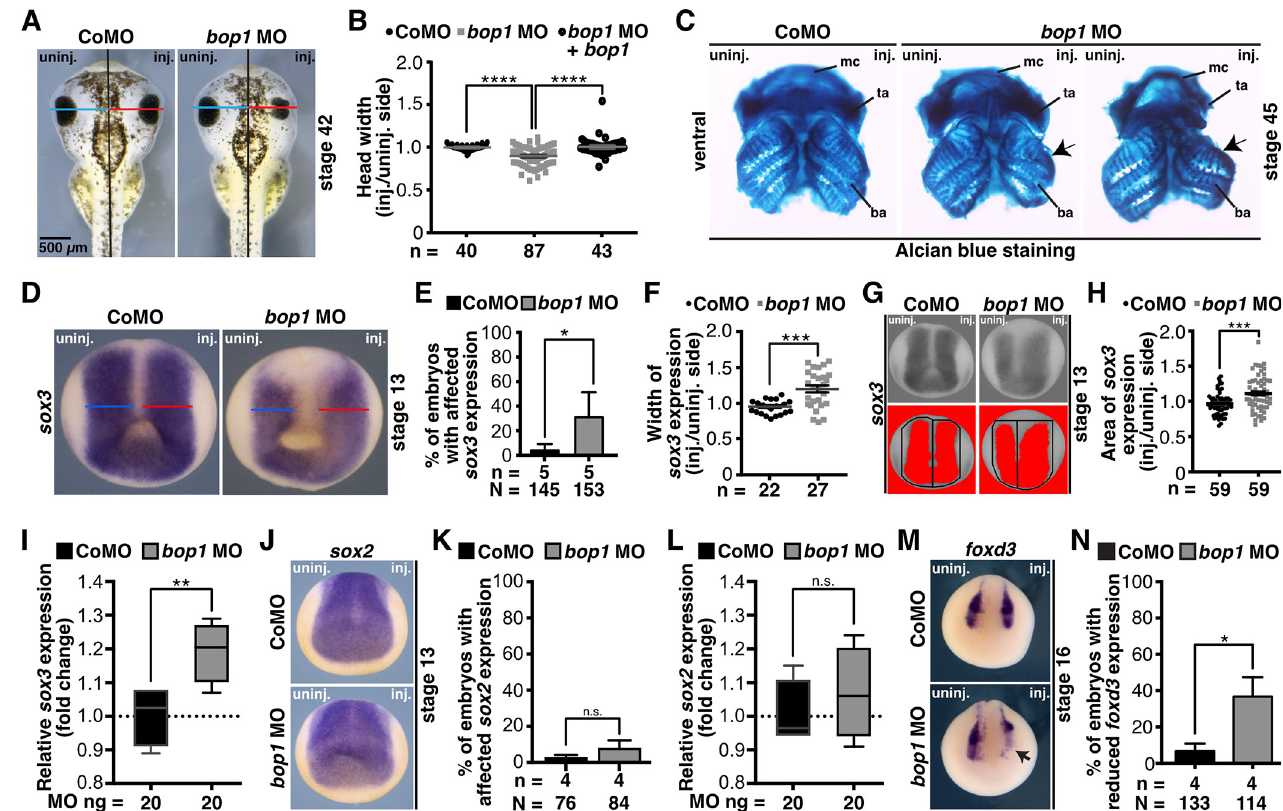
Fig 2. bop1 knockdown leads to a cranial cartilage phenotype. A The head width on the injected side (red line) of embryos at stage 42 injected with bop1 MO and Control MO was compared with the head width on the uninjected side (blue line). The head was significantly smaller upon bop1 knockdown. B Statistical evaluation of data given in A. The head phenotype was rescued by co-injecting bop1 MO with 0.5 ng of Δ 5’UTR-bop1 RNA. C Ventral view of Alcian blue- stained cranial cartilages of stage 45 embryos showed a reduced cartilage upon bop1 knockdown. The middle cartilage depicts a mild phenotype and the right one, a severe phenotype. Branchial arches (ba), Meckel´s cartilage (mc), tectum anterius (ta) were severely affected (black arrows). D sox3 served as pan-neural marker gene at stage 13 and was analyzed upon bop1 and Control MO injection. Anterior view of embryos is given. The width of sox3 expression on the injected side (red line) of bop1 MO- and Control MO-injected embryos at stage 13 was compared with the width on the uninjected side (blue line). E sox3 expression significantly increased in Xenopus embryos upon bop1 MO injection. F Statistical evaluation of data given in D showing an increased width of sox3 expression in bop1 morphants. G sox3 expression was analyzed in stage 13 bop1 morphants and control embryos (anterior view is shown). Expression domain was photographed and area was measured via ImageJ. Black boxes indicate area where sox3 expression (red area) was measured. Injected side was compared to uninjected side. H sox3 expression is significantly increased in bop1 morphants. Control MO injection did not alter sox3 expression. I Relative sox3 gene expression was analyzed using real-time qPCR in bop1 MO and Control MO bilaterally injected embryos at stage 13. sox3 expression was normalized to gapdh , odc , and slc35b1 and was significantly increased upon bop1 knockdown compared to control MO injection. J Anterior view of embryos is given. Expression of sox2 was analyzed upon bop1 MO and Control MO injection at stage 13. Neither bop1 MO nor Control MO injection affected sox2 expression. K Statistical analysis of data shown in J. L Relative sox2 gene expression was analyzed using real-time qPCR in bop1 MO and Control MO bilaterally injected embryos at stage 13. sox2 expression was normalized to gapdh , odc , and slc35b1 and was not affected upon bop1 knockdown. M The marker gene foxd3 in anterior neural crest cells in stage 17 embryos injected with 20 ng of bop1 MO or Control MO (black arrow indicates location of altered gene expression). N Around 40% of bop1 MO-injected embryos showed a reduced expression of foxd3 upon bop1 MO injection, but Control MO injection did not show any effect on foxd3 expression. Abbreviations: ba, branchial arches; bop1 MO, block of proliferation 1 morpholino oligonucleotide; CoMO, Control MO; inj., injected side; mc, Meckel´s cartilage; MO, morpholino oligonucleotide; n, number of independent experiments; N, number of injected and analyzed embryos; n.s., non- significant; ta, tectum anterius; uninj., uninjected side. bop1 is the Δ 5’UTR-bop1 RNA used for rescues. Error bars indicate standard error of the means; Whiskers indicate in I and L minimum and maximum. � , p � 0.05; �� , p � 0.01; ��� , p � 0.001; ���� , p �